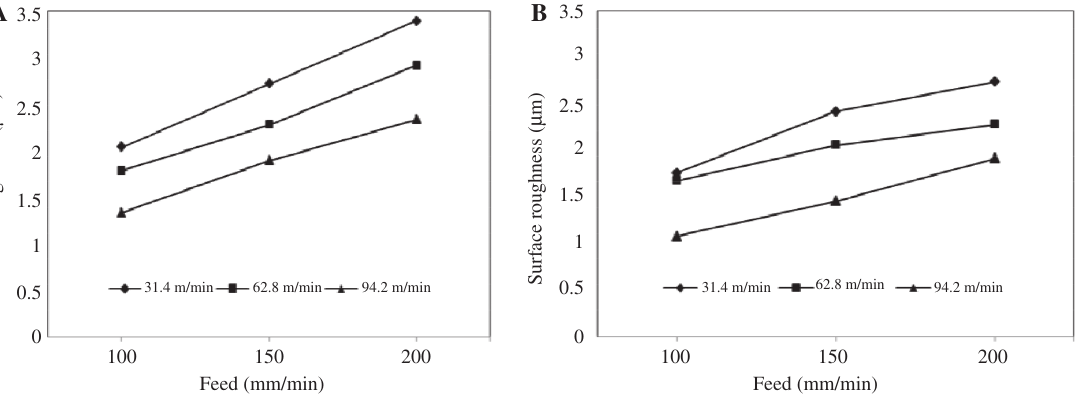
Figure 7 Influence of the cutting parameters on surface roughness at different number of flutes: (A) three flutes and (B) four